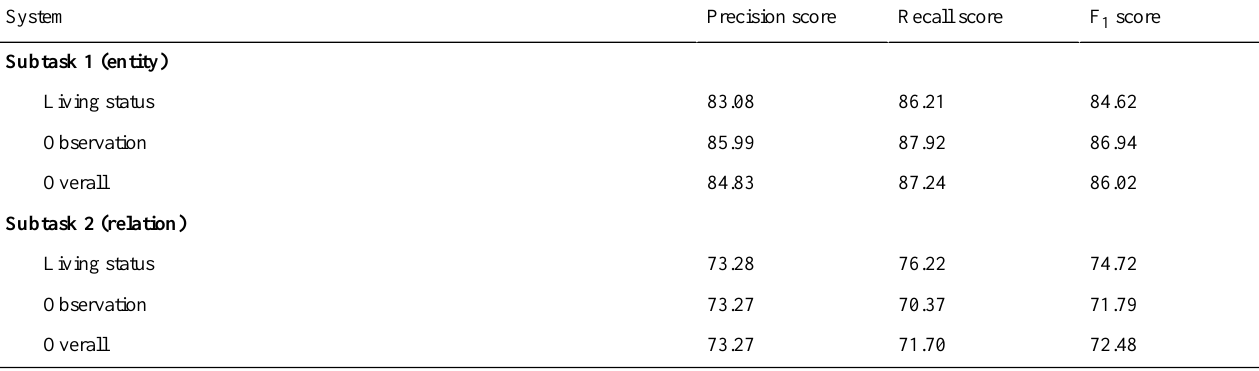
Table 5. Results of full-featured system for each relation category.